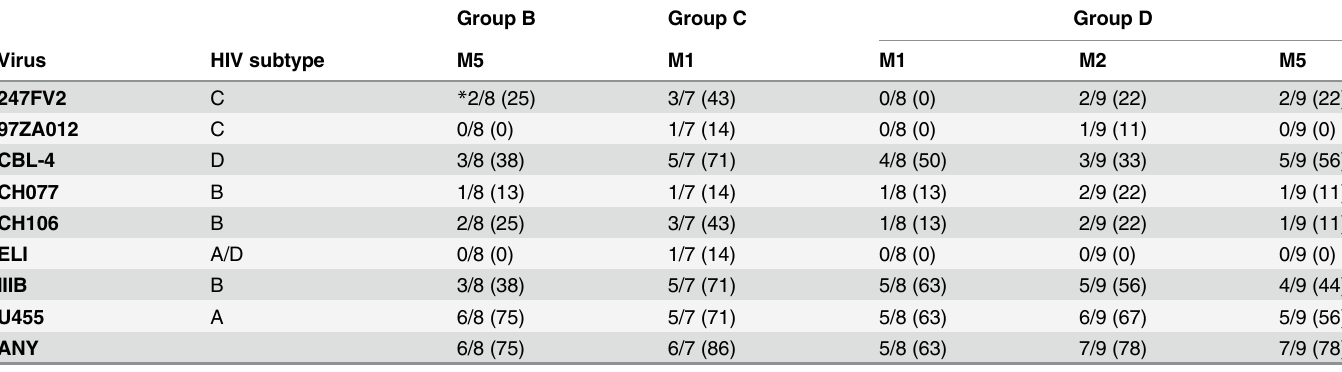
Table 2. VIA response rate at 4 weeks after each Ad35-GRIN